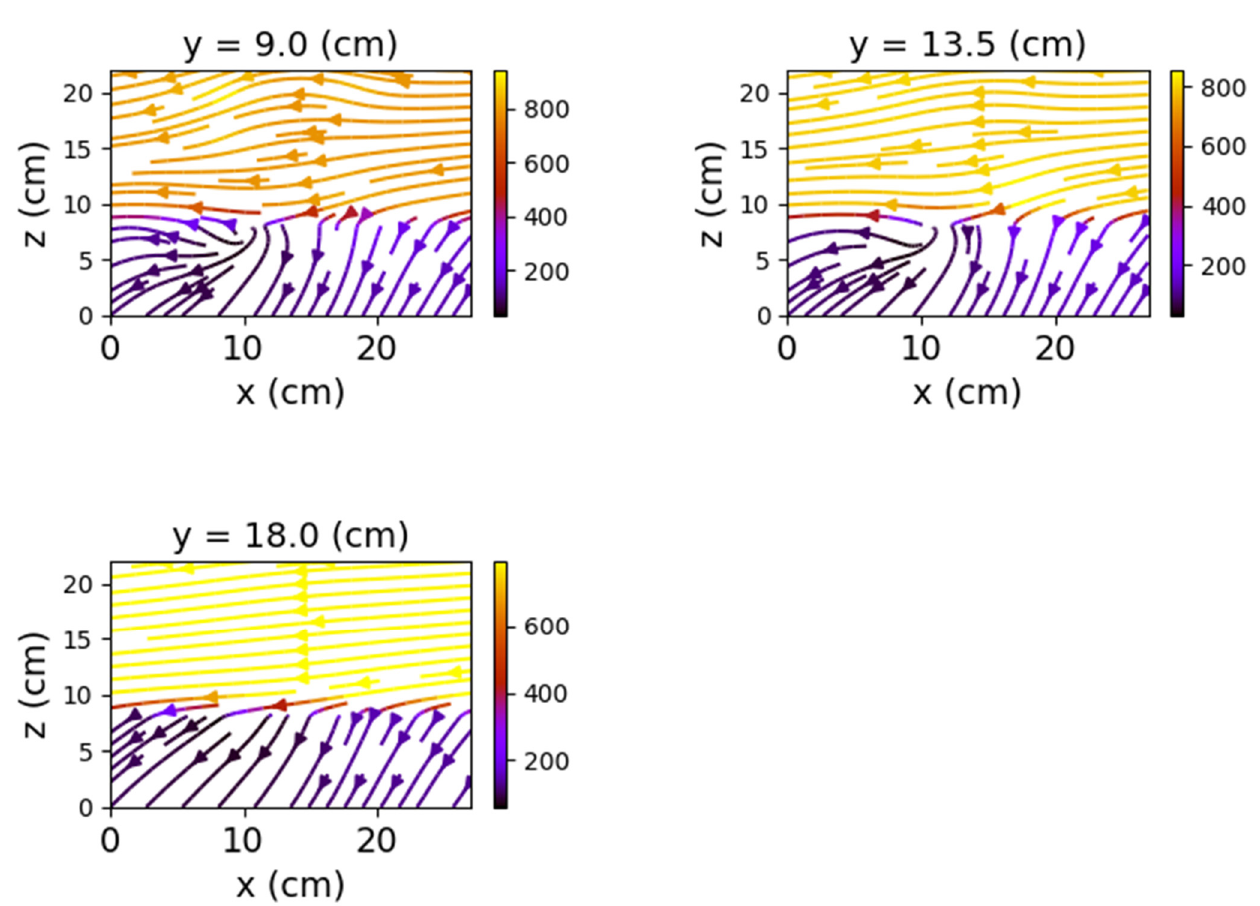
Figure 13. Field lines for x O z plane—relay with both coils powered.